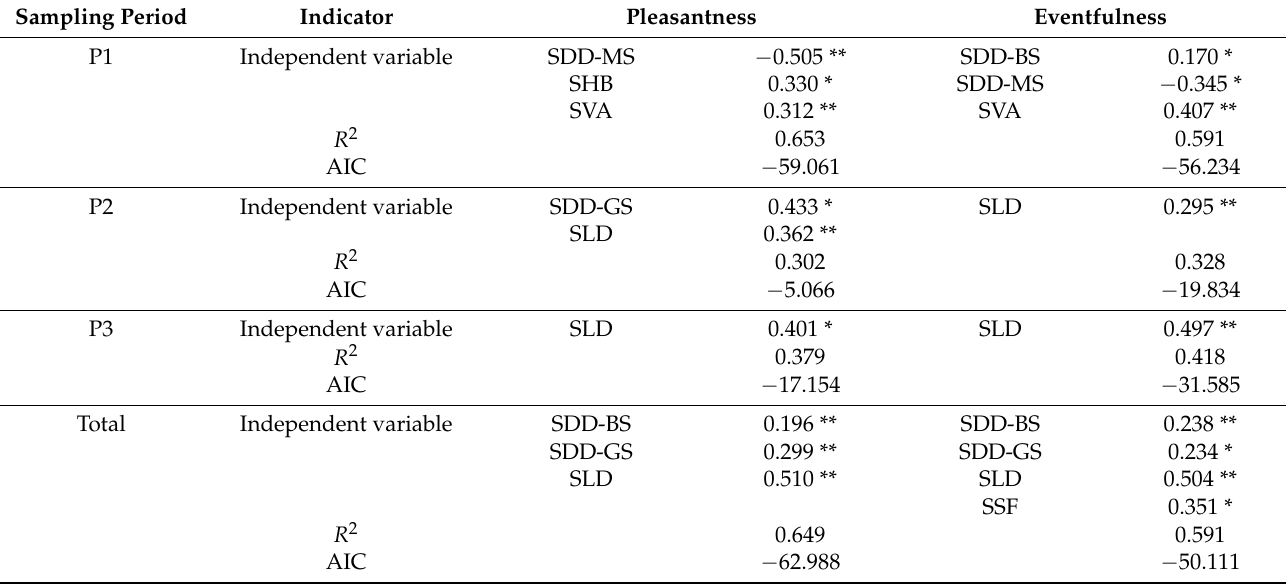
Table 4. Results of the OLS model (* p < 0.05, ** p <